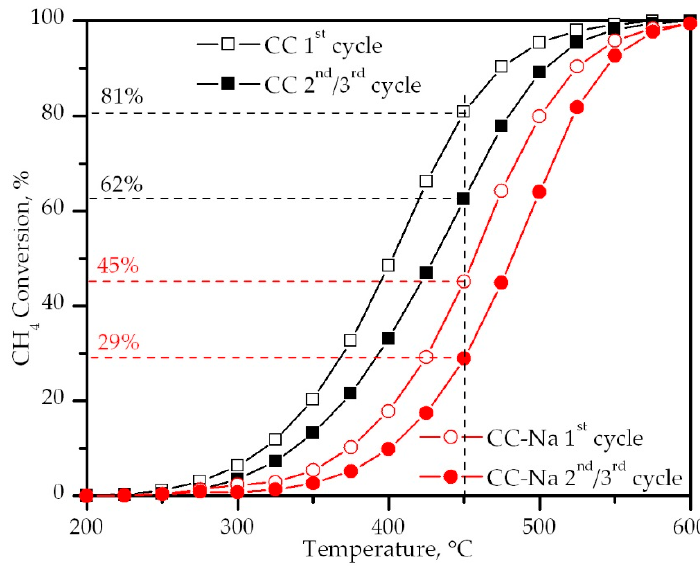
Figure 9. Light-off curves of the catalysts.